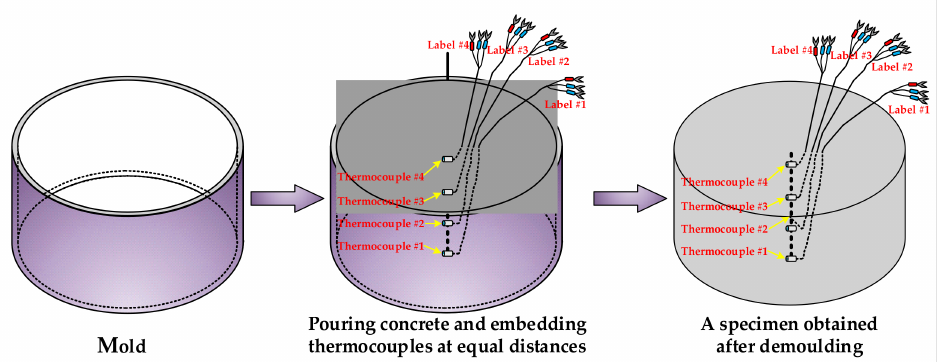
Figure 4. Preparation process of specimens: ( a ) Embedding the thermocouples, ( b ) attaching numbered labels, ( c ) a prepared specimen.